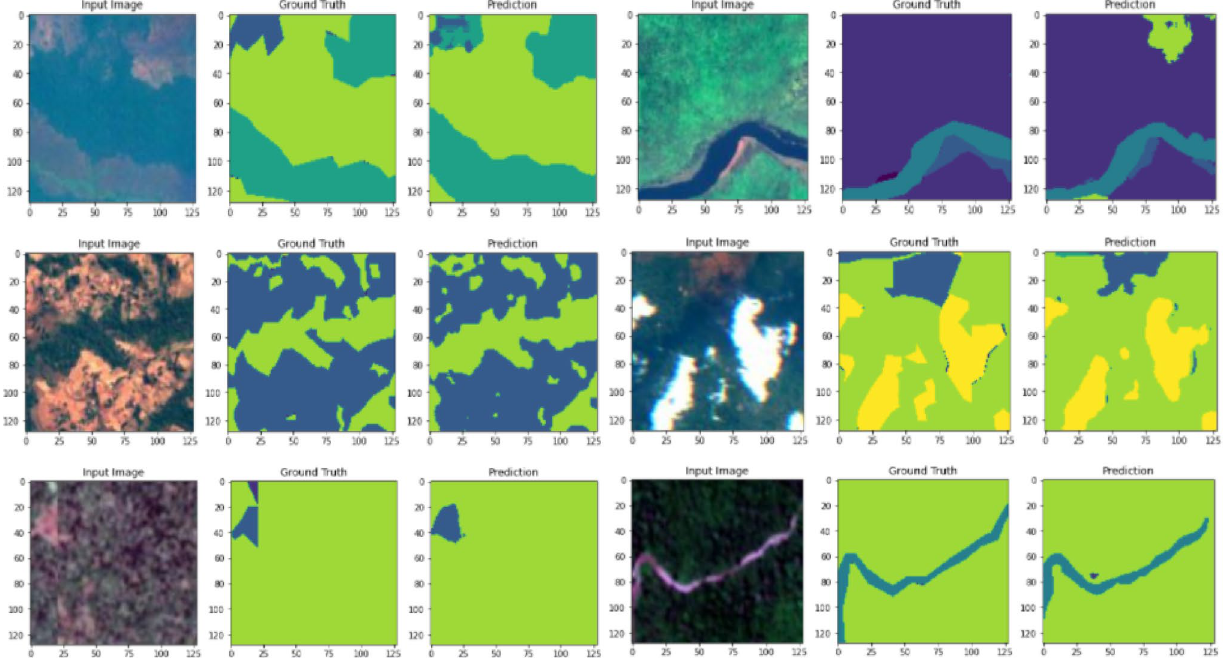
Fig. 7 Sample input images with their ground truth and predicted